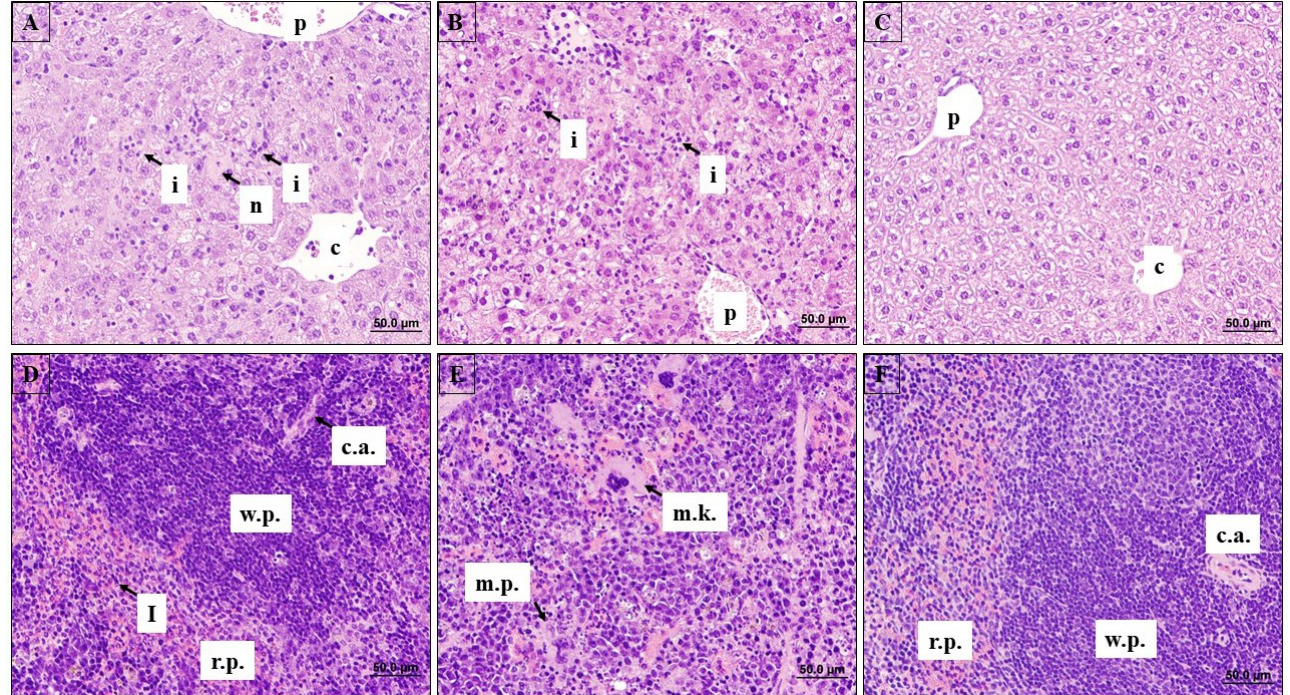
Figure 6. Histopathological Analysis of Liver and Spleen following SUDV Challenge in STAT-1 KO Mice. Representative liver sections showing infiltration of neutrophils (i) and necrosis (n) ( A , B ). Liver section from mock-infected animal ( C ). Representative spleen sections showing infiltration of neutrophils (i), megakaryocytes (m.k.), and myeloid precursors (m.p.) ( D, E ). Spleen section from mock-infected animal ( F ). Additional legends: portal vein (p), central vein (c), red pulp (r.p.), white pulp (w.p.), central artery (c.a.).